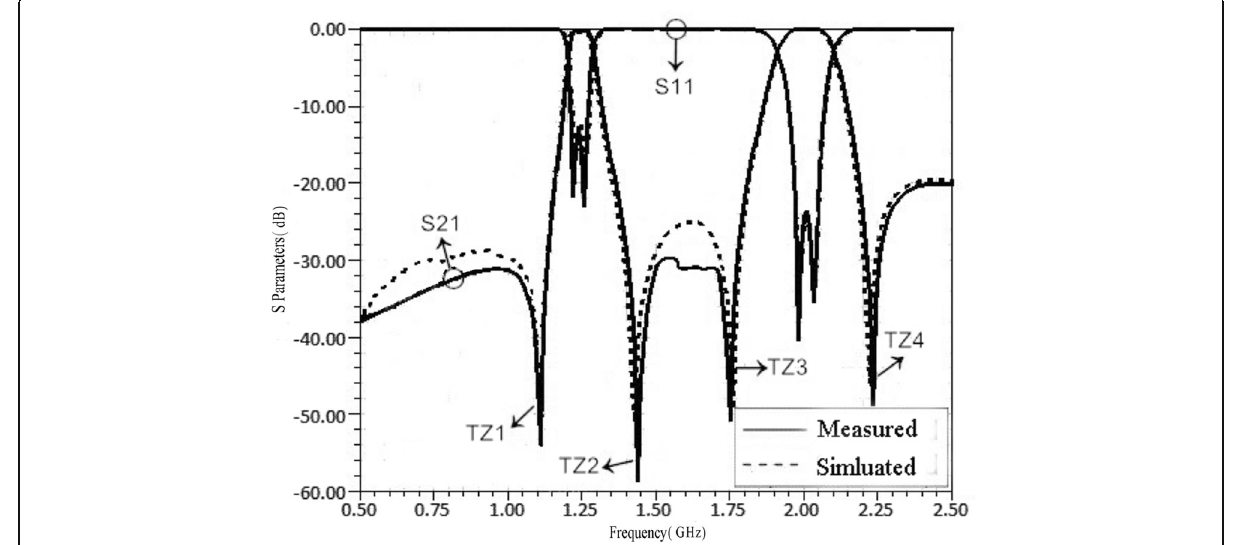
Fig. 6 Frequency responses of the filter with four transmission